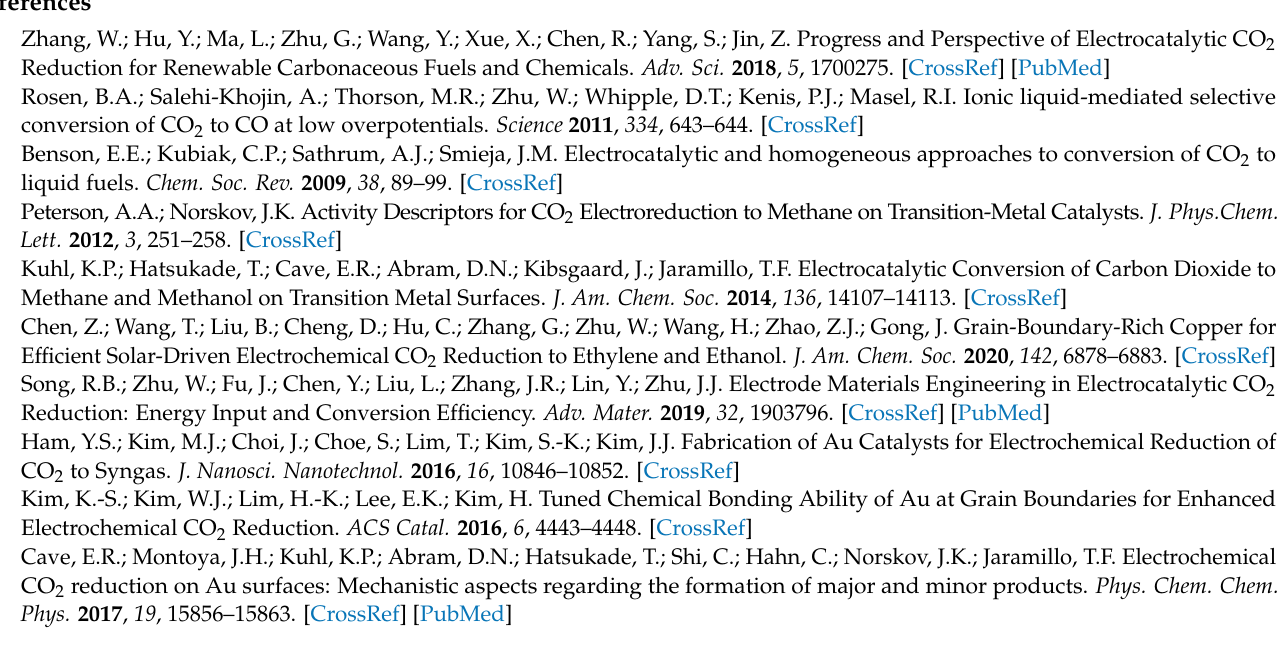
Figure S3: Thermogravimetric analysis (TG) profiles for the Ag/CM precursors during the calcination process; Figure S4: SEM images of different CD-Ag electrodes after 5 h electrolysis: (a) 10 CD-Ag; (b) 15 CD-Ag and 20 CD-Ag, respectively; Figure S5: The deconvoluted peak of (a) Ag 3d and (b) O 1s of 10 CD-Ag material and (c) Ag 3d and (d) O 1s of 20 CD-Ag material; Figure S6: CO partial current density depending on applied potential, and (b) mass activity depending on applied potential; Figure S7: Current density and FE of CO during 5 h of long-time operation at − 0.95 V vs. RHE for (a) Ag foil; (b) 10 CD-Ag; (c) 20 CD-Ag electrode, respectively; Figure S8: CV curves on (a) Ag foil; (b) 10 CD-Ag; (c) 15 CD-Ag; (d) 20 CD-Ag electrode with a potential range from 0.65 to 0.45 V vs. RHE in a CO 2 bubbled 0.1 M KHCO 3 electrolyte; Figure S9: Tafel plots of the CO partial current density for Ag foil and CD-Ag. Table S1: The elemental compositions of three CD-Ag samples obtained from EDS; Table S2: Comparison of catalytic performances of our catalyst with different Ag-based electrocatalysts producing CO in the literature. References [44,45] are cited in the supplementary